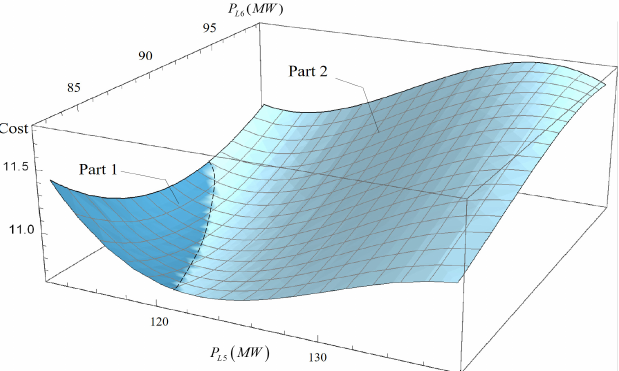
Figure 8. Surface of objective function with P L5 ∈ [ 112.5,137.5 ] MW, P L6 ∈ [ 81,99 ] MW. Part 1 in dark blue: δ G2 encounters its upper limit in fault 2. Part 2 in light blue: δ G2 encounters its upper limit in fault 1.